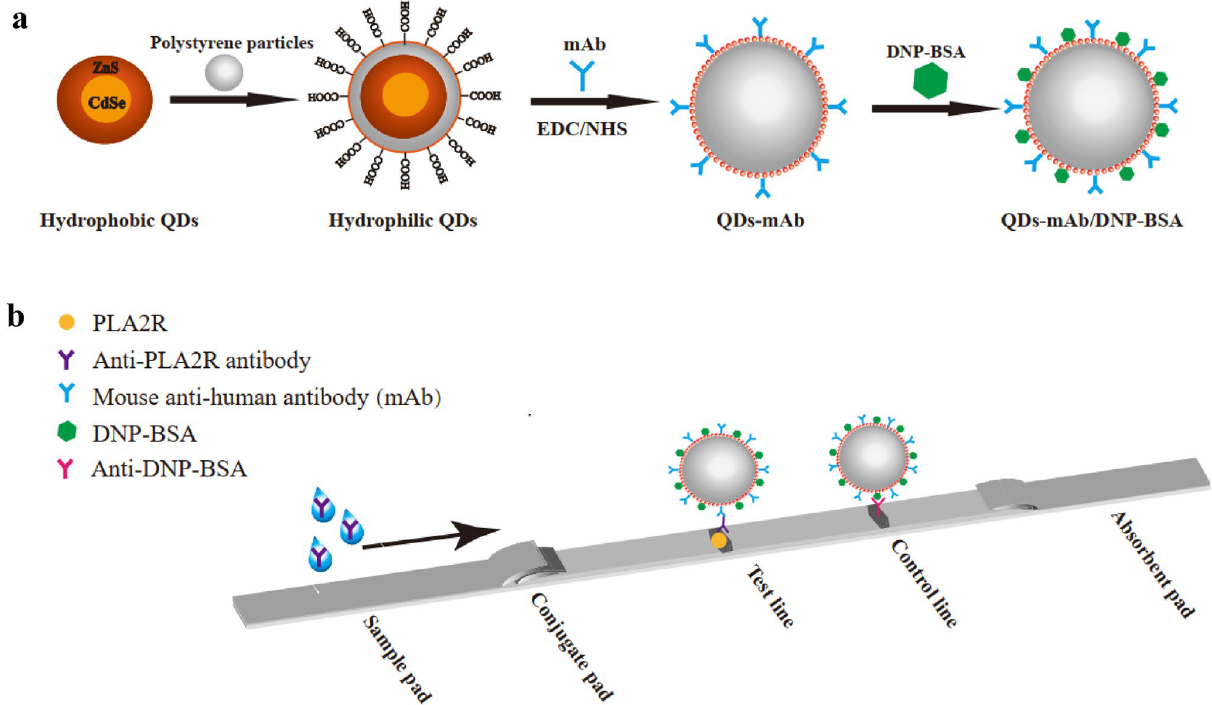
Figure 1. Quantum dot conjugate formation and antibody detection. Schemes used for ( a ) quantum dots– antibody conjugate synthesis and ( b ) identification of anti-PLA2R antibodies. QDs quantum dots, mAb monoclonal antibody, DNP-BSA N-2,4-dinitrophenylated-bull serum